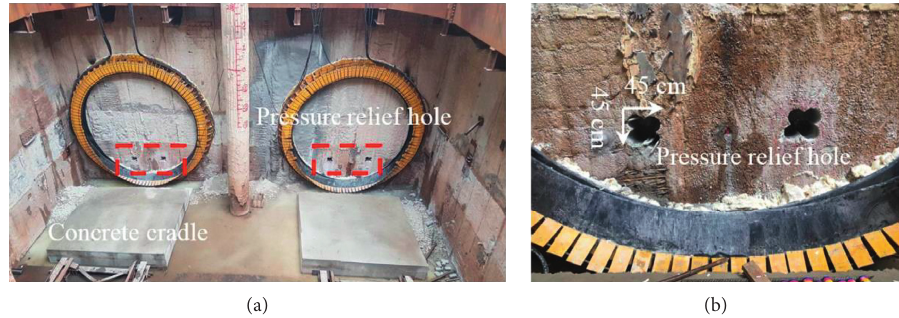
Figure 9: Distribution of pressure relief holes: (a) overall view and (b) partial view of pressure relief holes.